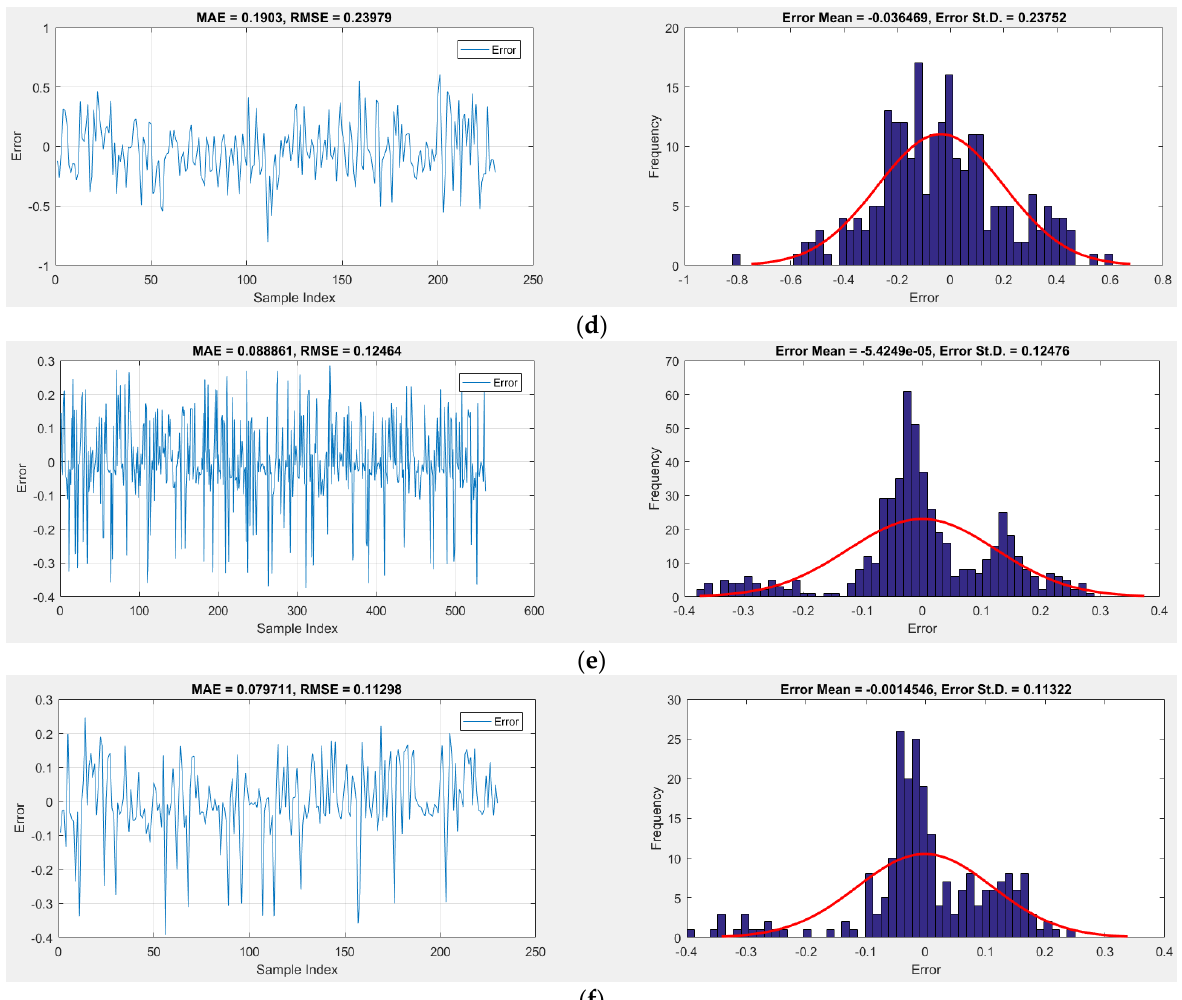
Figure 5. The error analysis for the best-fit proposed model for the ( a ) MVO − MLP training dataset, ( b ) MVO − MLP testing dataset, ( c ) SOSA − MLP training dataset, ( d ) SOSA − MLP testing dataset, ( e ) VSA − MLP training dataset, and ( f ) VSA − MLP testing dataset.